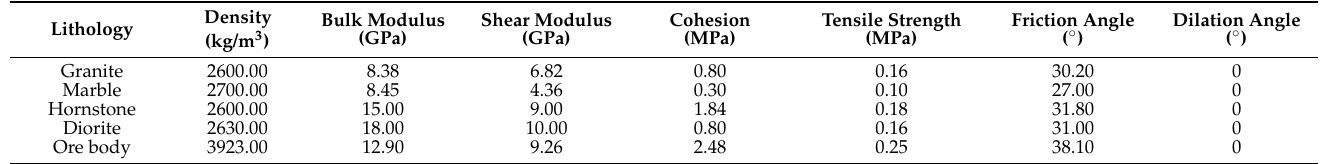
Table 4. Mechanical parameters of the rock